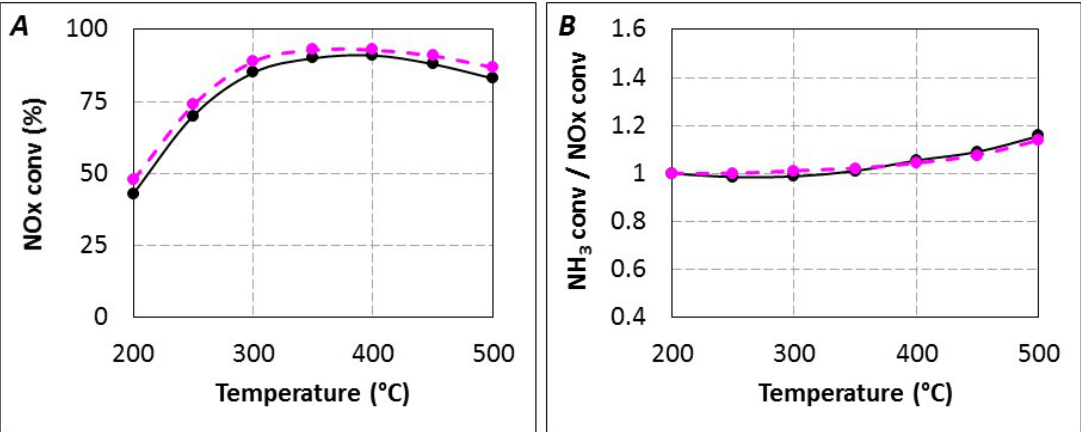
Figure 1. Urea-SCR ( ▬ , t R = 5.2 s) and NH 3 -SCR (▬) under standard condition (400 ppm NO, 400 ppm Equation NH 3 , 8% H 2 O, 10% CO 2 , 10% O 2 ). ( A ) NO x conversion; ( B ) NH 3 conversion/NO x conversion ratio. Table 1. (NH 3 conversion/NO x conversion) ratio depending on the temperature and the reductant. Reductant Temperature NH 3 Urea, t R = 5.2 s/6.2 s Urea, t R = 4.0 s Urea, t R = 4.0 s + ZrO 2 (150 mg) 200 °C 1.00 1.00 1.00 1.03 250 °C 1.00 0.99 1.03 1.01 300 °C 1.01 0.99 1.03 1.01 350 °C 1.02 1.01 1.16 1.01 1.04 1.05 1.20 1.07 1.08 1.09 1.16 1.15 500 °C 1.14 1.16 1.36